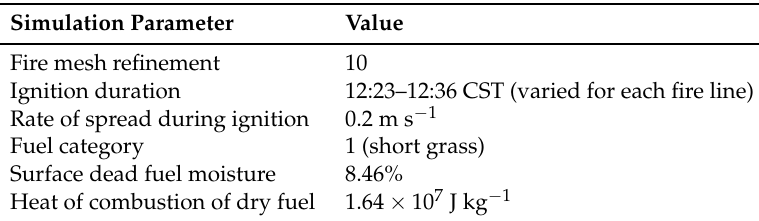
Table 2. Details of fire and ignition parameters in LES